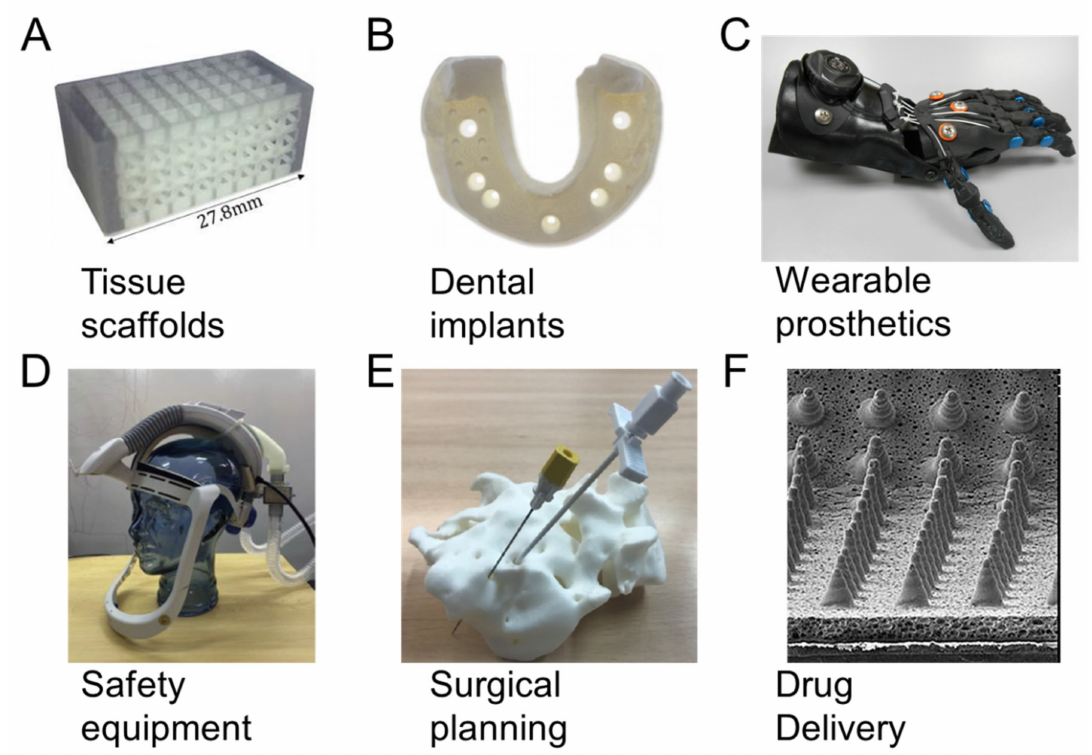
Figure 5. Medical 3D printing applications for ( A ) spinal fusion cage [95], ( B ) dental model [96], ( C ) prosthetic hand [97], ( D ) personal protection equipment [12], ( E ) sacral surgery planning [8], and ( F ) drug-delivering microneedles [98]. Images adapted with